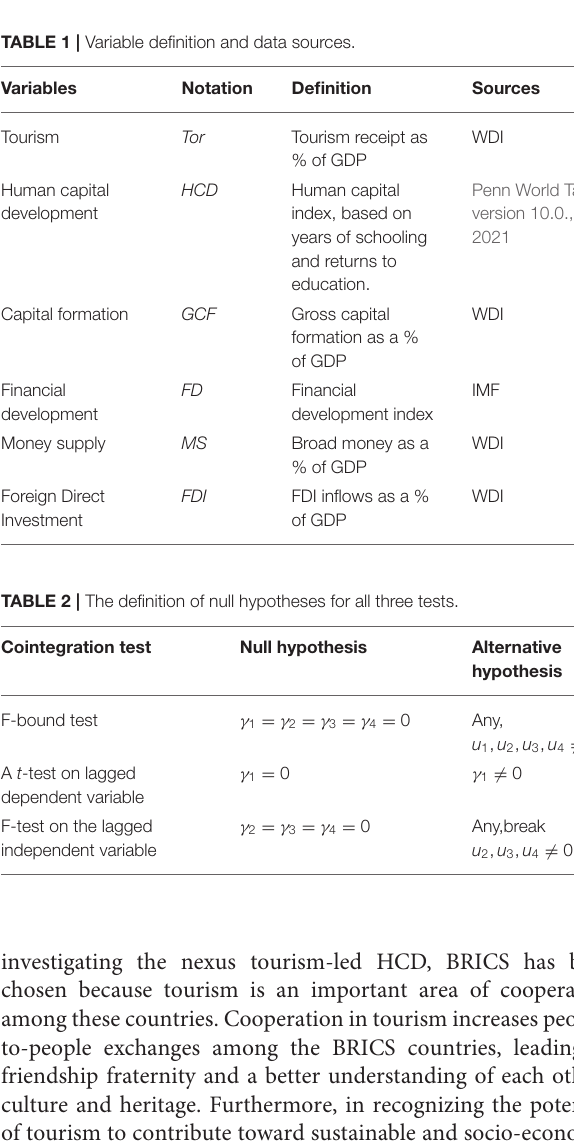
TABLE 1 | Variable definition and data sources.